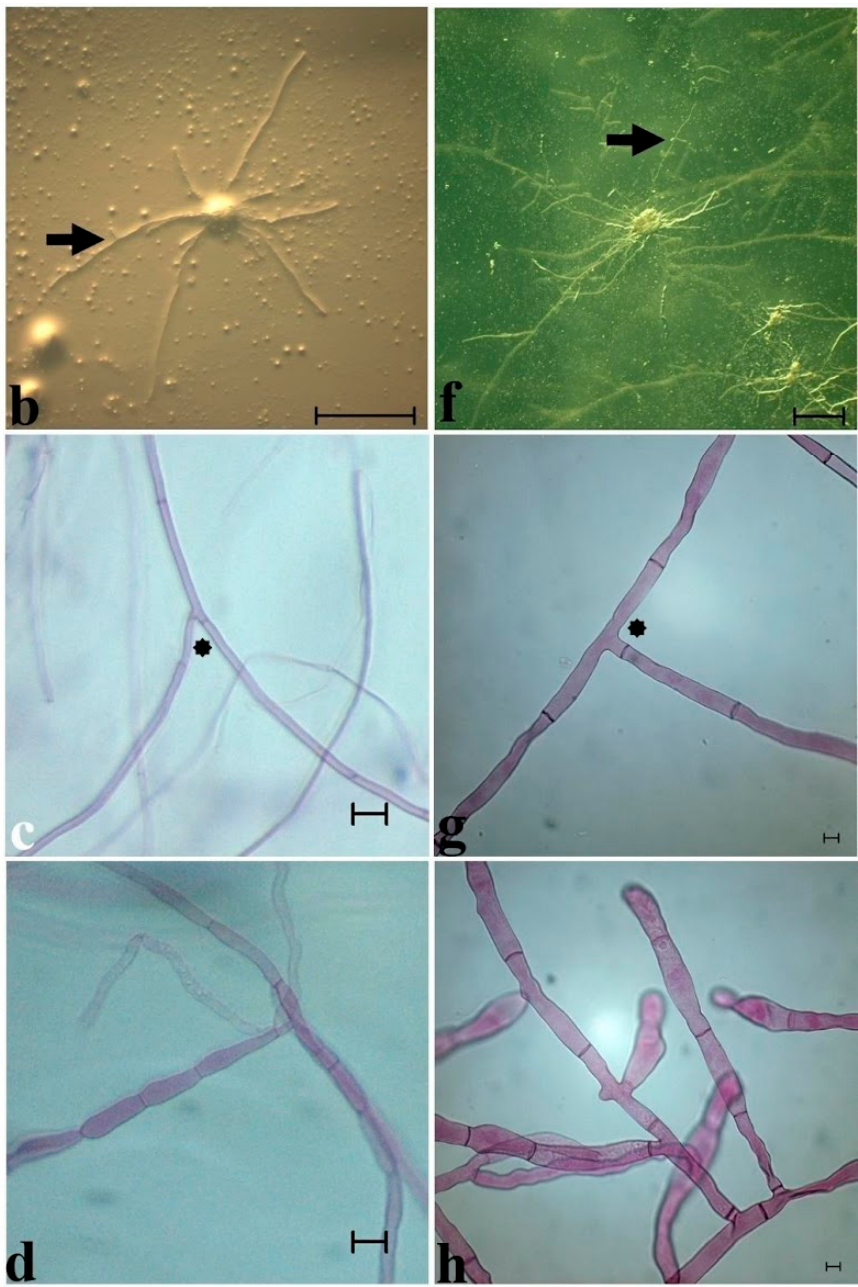
Figure 8. Mycorrhizal isolates of Mesoamerican Cypripedium . Isolate from Cypripedium irapeanum ( a – d ) and from C. molle ( e – h ). ( a ) Colony view of Epulorhiza sp. ( Tulasnella sp.) from a tropical dry forest in Veracruz State showing a submerged mycelium, yellow-creamy color, and waxy surface. ( b ) Superficial growth after 5 days of incubation of straight hyphae obtained from a peloton after sowing on GPA medium showing 90 ◦ bifurcation of the hyphae (black arrow). Bar = 100 µ m. ( c ) Mycelium from an isolated culture showing less than 4 µ m hyphae and straight basal septa (black asterisk). Bar = 10 µ m. ( d ) Monilioid cells. Bar = 10 µ m. ( e ) Colony view of Ceratorhiza sp. ( Ceratobasidium sp.) that was isolated from a Quercus forest in Oaxaca State showing an aerial mycelium, brownish-creamy color, and cottony superficial aspect. ( f ) View of hyphae growing from a submerged peloton with a knobby appearance after 3 days of incubation. Bar = 10 µ m. ( g ) Mycelium from an isolated culture showing hyphae longer than 4 µ m and constrained basal septa (black asterisk). Bar = 10 µ m. ( h ) Monilioid cells. Bar = 10 µ m. Photos taken by Mauricio Moreno in